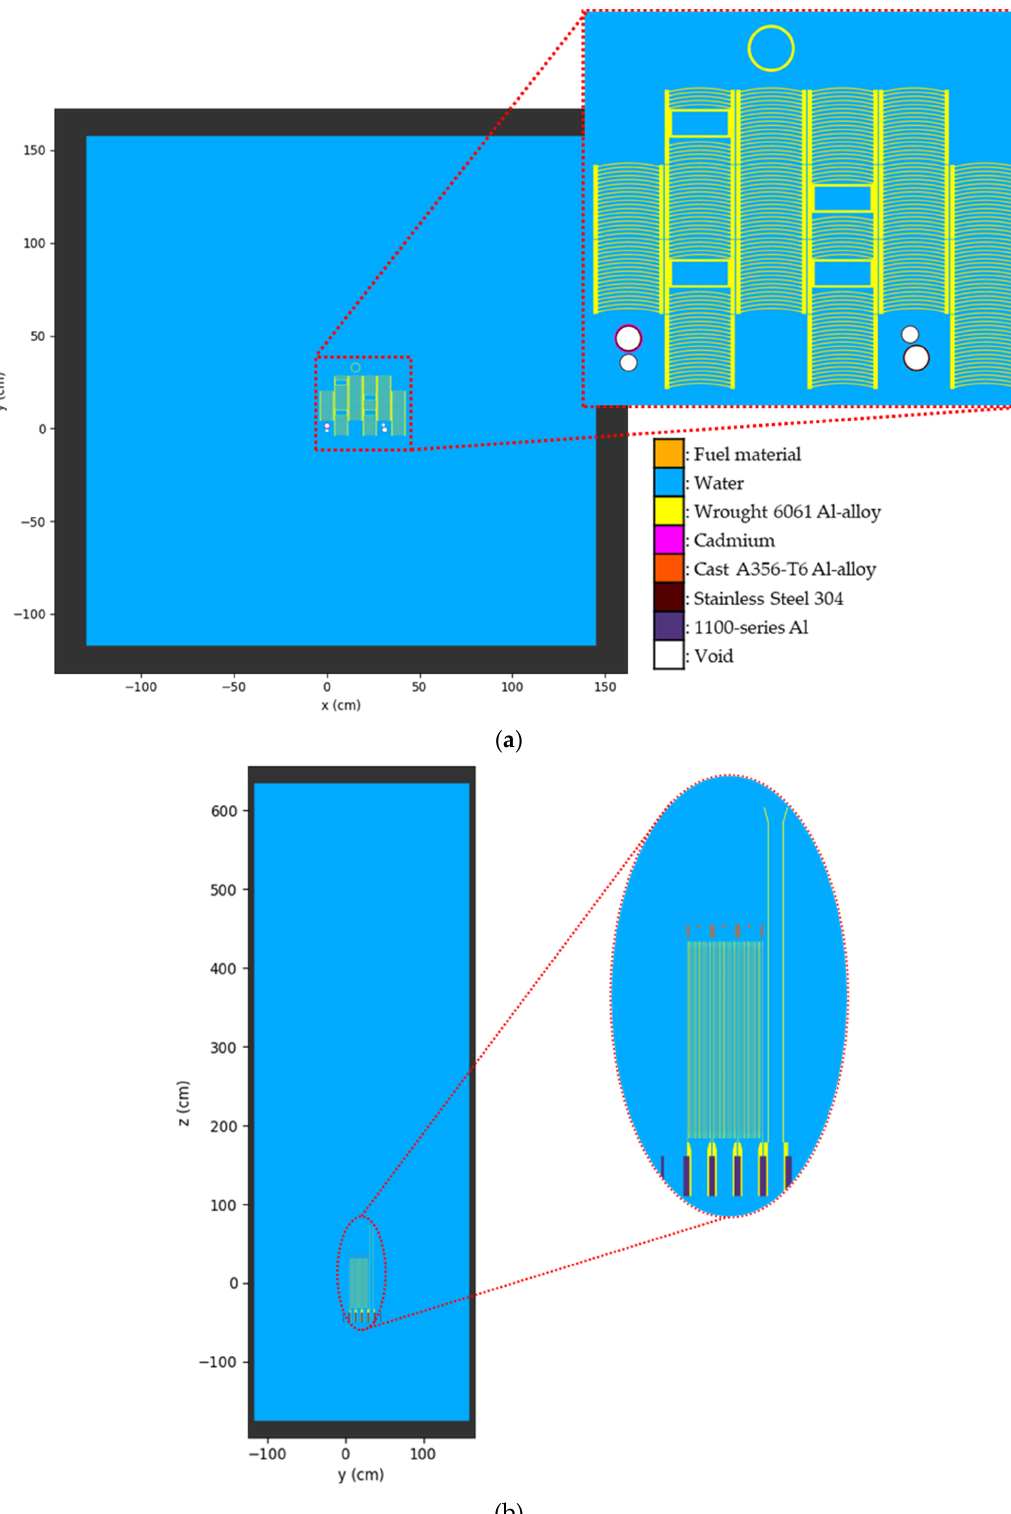
Figure 7. Full cross-sectional view of the OpenMC model: ( a ) XY-axis plan view with color code; ( b ) YZ-axis plan view, where the black borders represent the model geometric boundary.